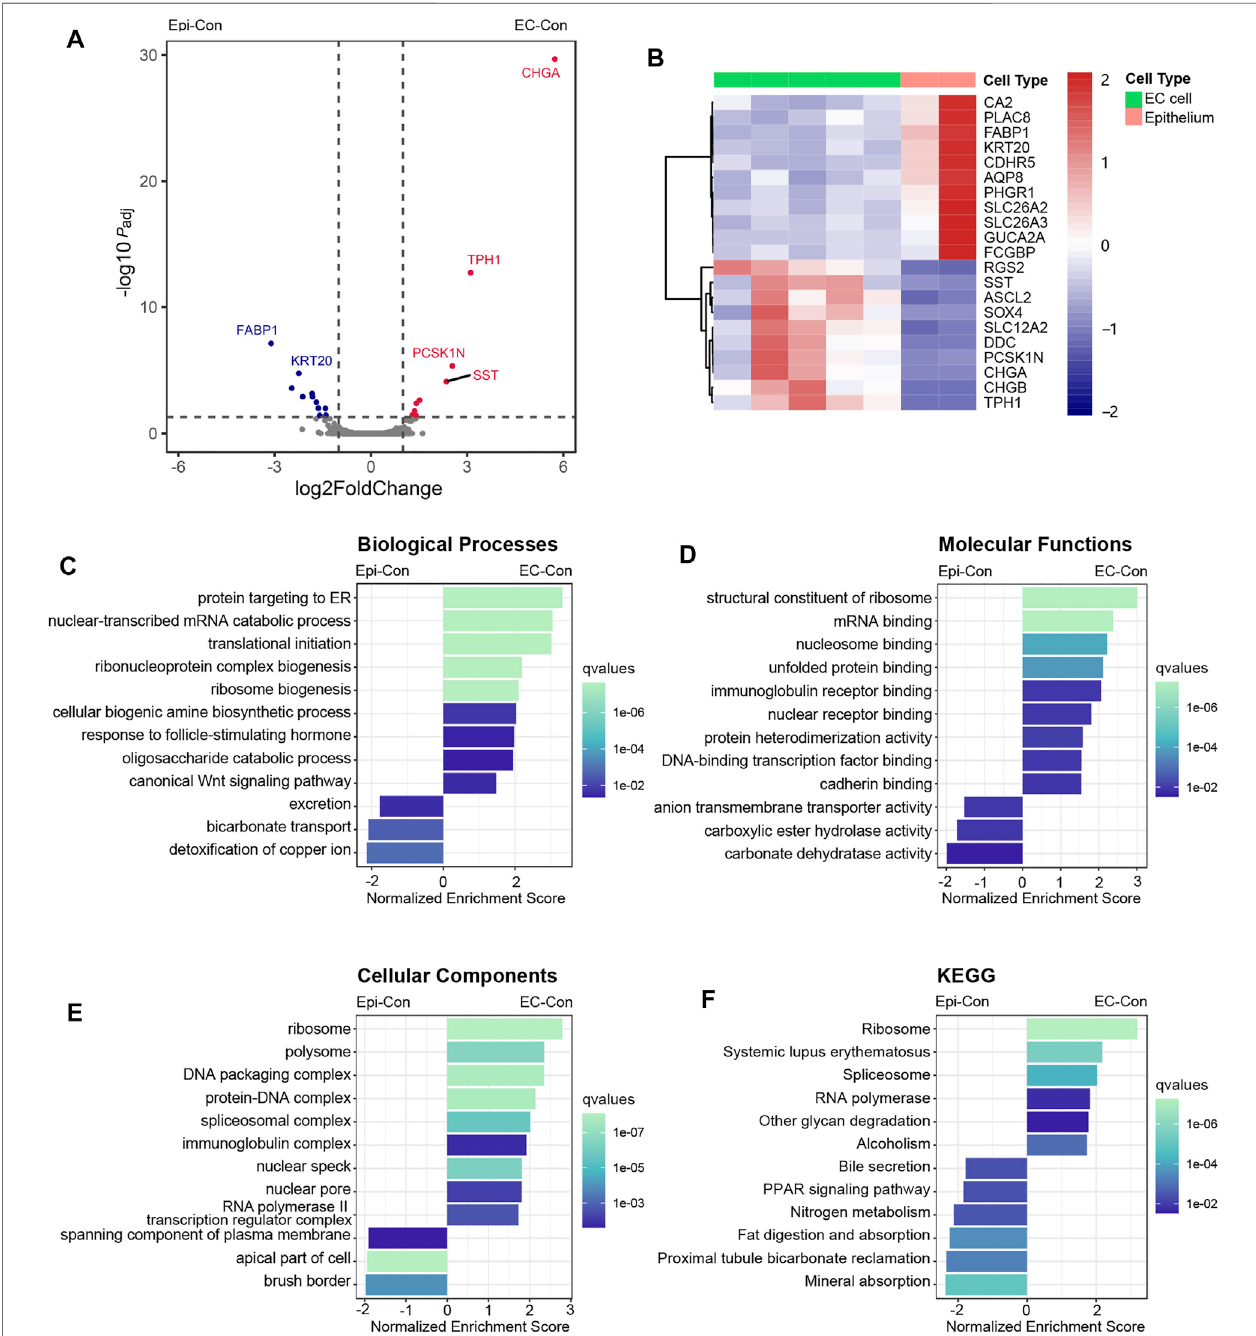
FIGURE2| ComparisonbetweenECcellsandbackgroundepitheliuminhealthyparticipants,revealingthedistinctiveexpressionpatternsofECcells.Participants, revealing the distinctive expression patterns of EC cells. (A) Volcano plot of the analysis of differential expression between the EC-Con and Epi-Con groups. Vertical dotted lines represent log2FoldChange values of 1 and − 1. The horizontal dotted line represents adjusted P = 0.05. P adj , adjusted p -value. (B) Heatmap of DEGs betweenEC cellsand backgroundepitheliumin healthy participants. (C – F) Results ofGSEA comparing the EC-Con and Epi-Congroups. Analysiswasperformed using the GeneOntology categories ofbiological process (C) ,molecularfunction (D) ,and cellular component (E) , aswell asKEGGpathways (F) .Thelengthofeach bar indicates the normalized enrichment score, and the color indicates q values of each term.